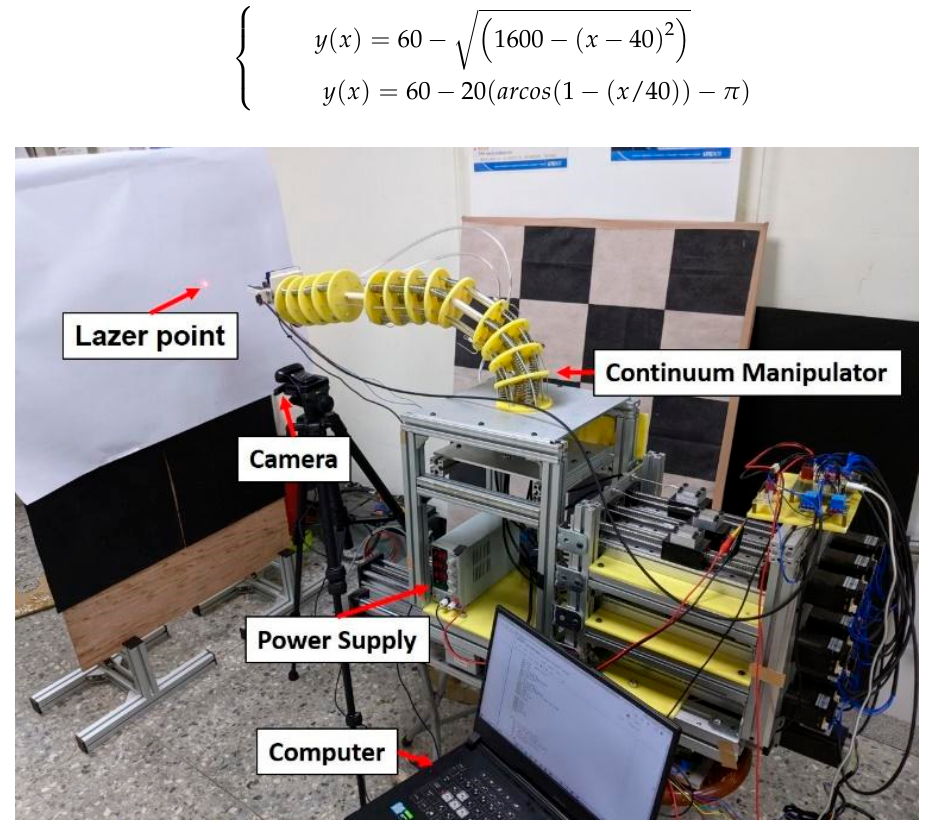
Figure 15. The environment of the trajectory tracking.